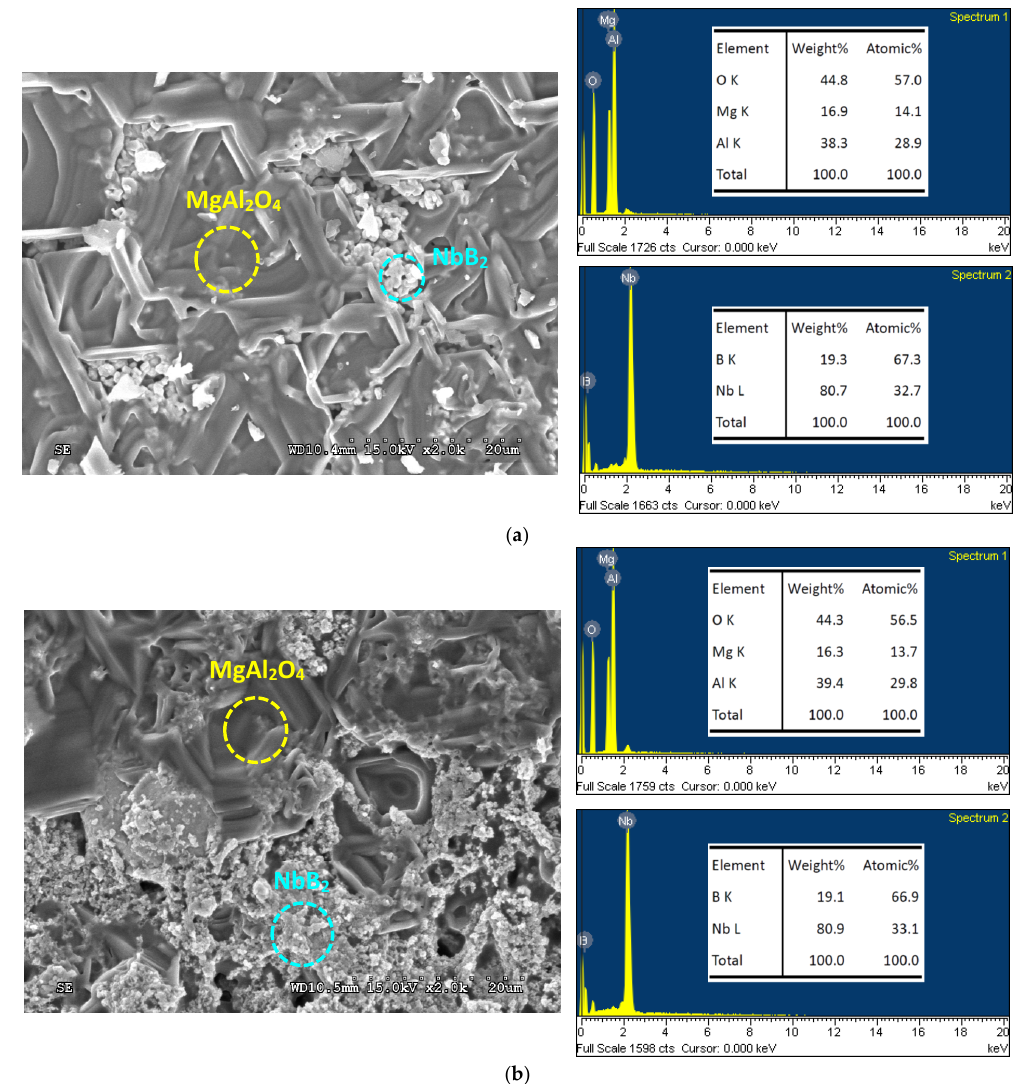
Figure 8. SEM micrographs and EDS spectra of NbB 2 –MgAl 2 O 4 composites of ( a ) Reaction (1) of x = 1.0 with 30 atom.% excess boron and ( b ) Reaction (2) of y = 1.6 with 30 atom.% excess